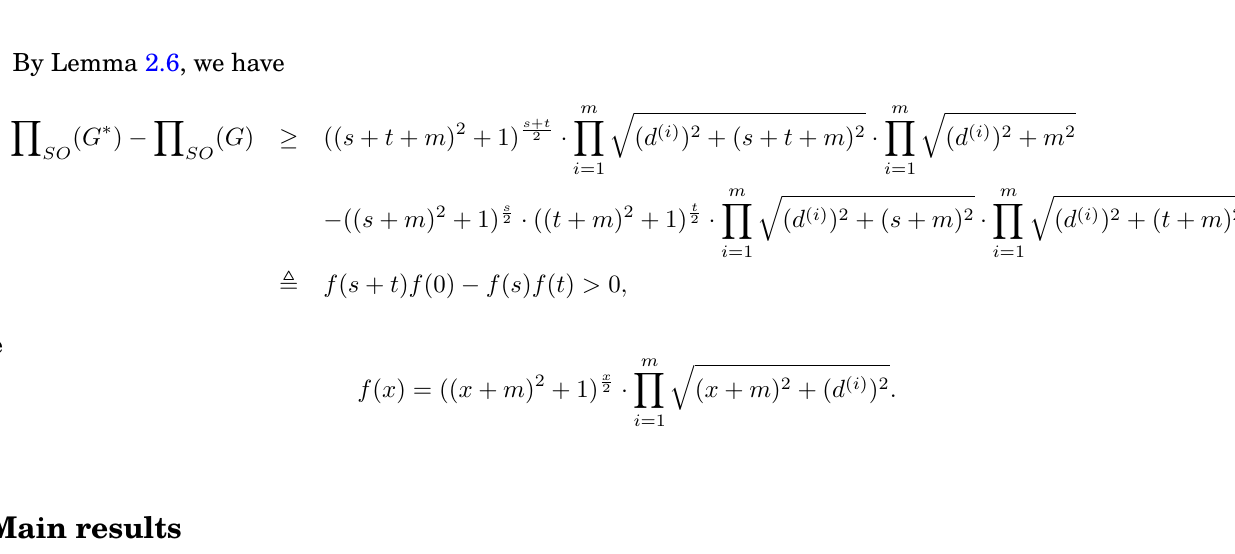
Figure 5: Transformation E